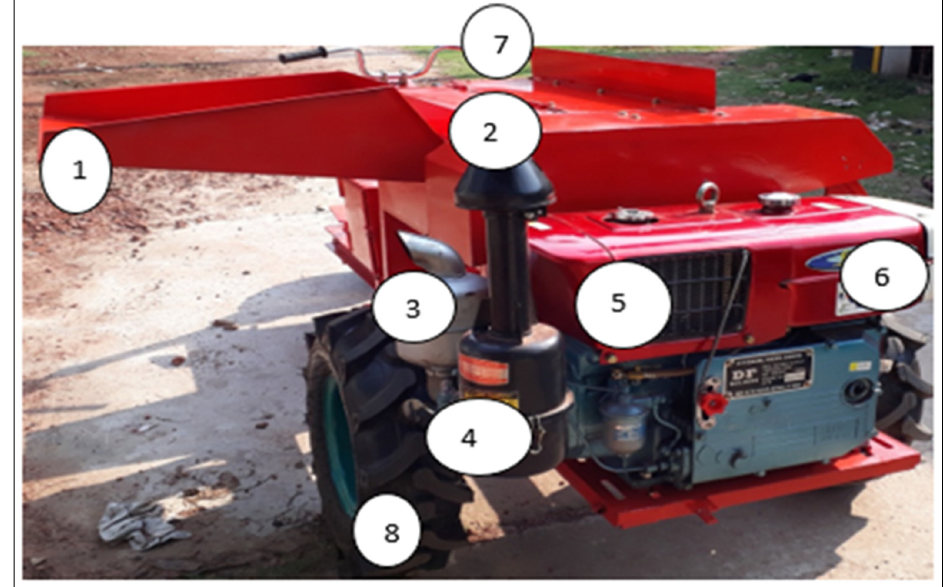
Figure 4. Different components of the Aashkol are shown in the pictorial view from the back. 1. Feeding tray; 2. Protection cover; 3. Silencer; 4. Air cleaner; 5. Coolant tank; 6. Fuel tank; 7. Handle, 8. Wheel.